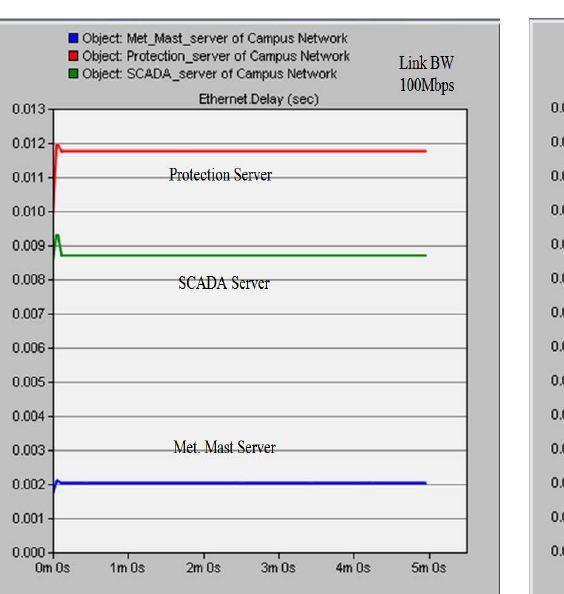
Figure 11. ( a ) Average ETE delay for small-scale WPF with link BW 100Mbps; ( b ) Average ETE delay for small-scale WPF with link BW